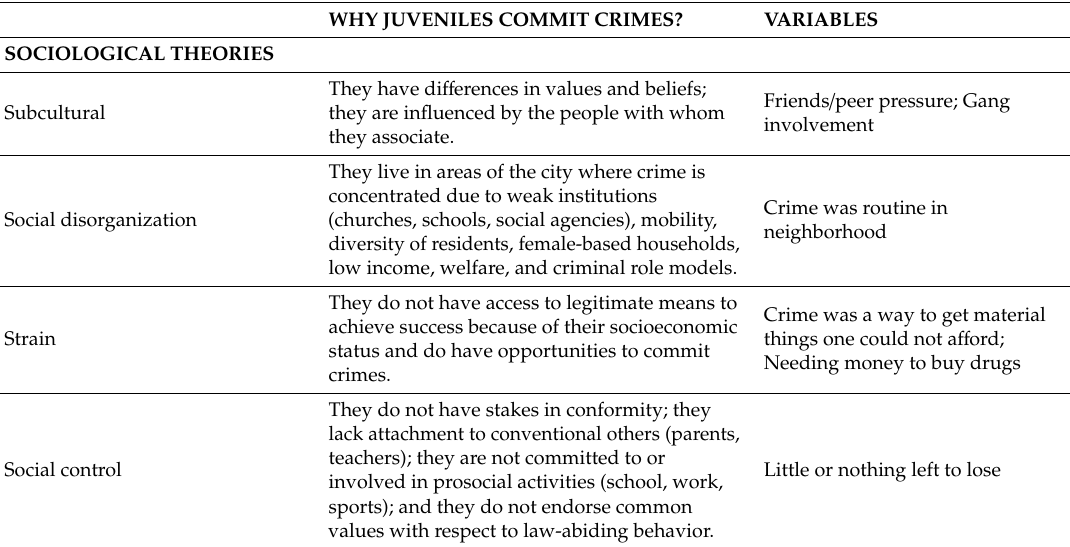
Table 2. Sociological explanations of